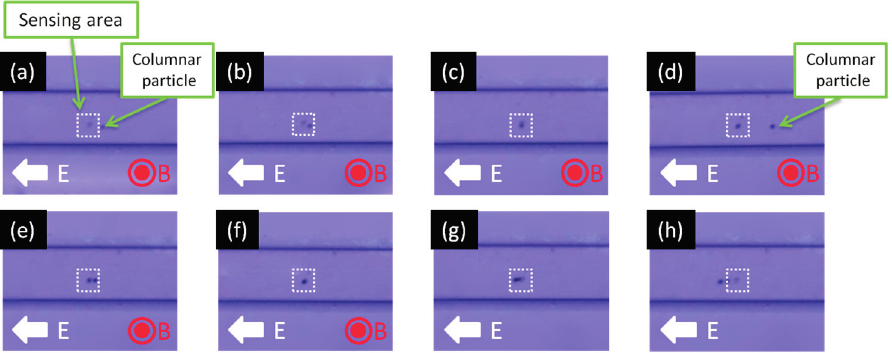
Figure 13. ( a – h ) Sequence optical images of electrostatic manipulation movement of columnar particles in micro channel filled with aqueous solution and detection of 130 nm diameter target particles via magnetically induced self-assembly of columnar particles. ( a , b ) Movement of a single 2.8 μ m diameter magnetic particle in the microchannel; ( c ) The micrometer sized particle is magnetically captured by the immobilized target particles; ( d , e ) Another columnar particle is moved towards the location where the previous 2.8 μ m diameter particle was captured; ( f ) Another columnar particle self-assembles onto the previous bead. ( g , h ) Columnar particles begin to move through the microchannel again in the absence of an external magnetic field due to the electric force still acting on the columnar particles. Adapted from